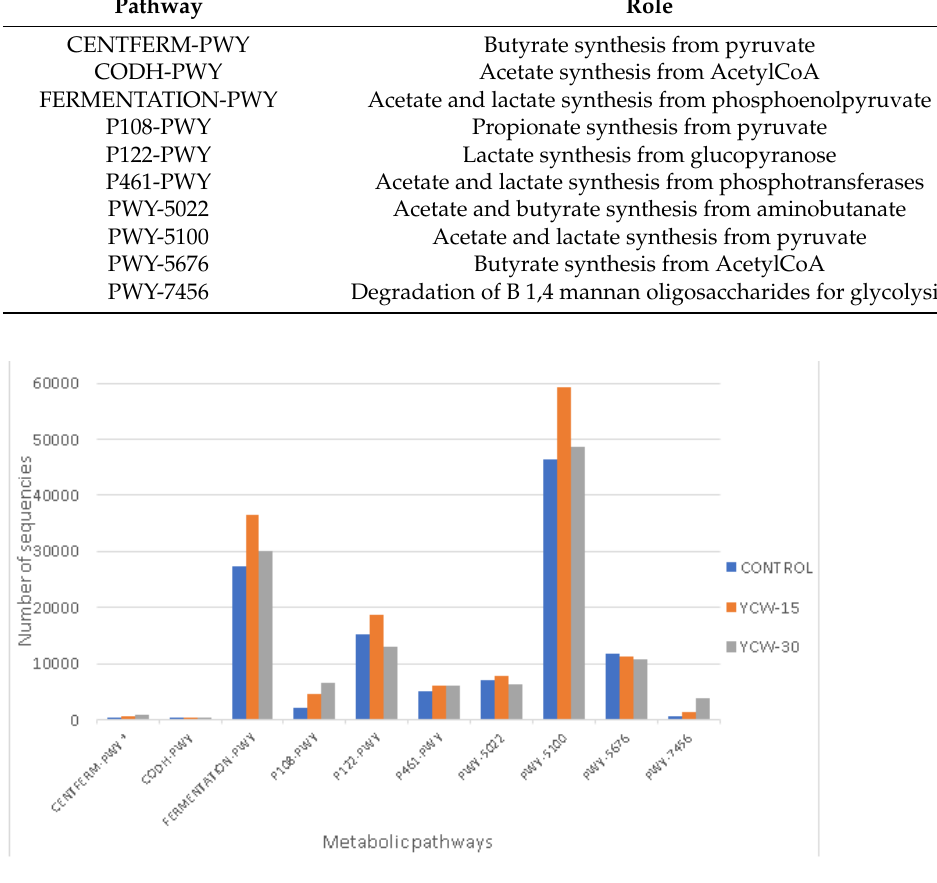
Figure 6. Variation of metabolic pathways of the main bacterial fermentation sequences of the 16S rRNA gene determined via MetaCyc. * Pathway with differences among treatments. The CENTFERM-PWY pathway tended to be different ( p = 0.086) in the YCW-30 group compared to the control (Figure 7).